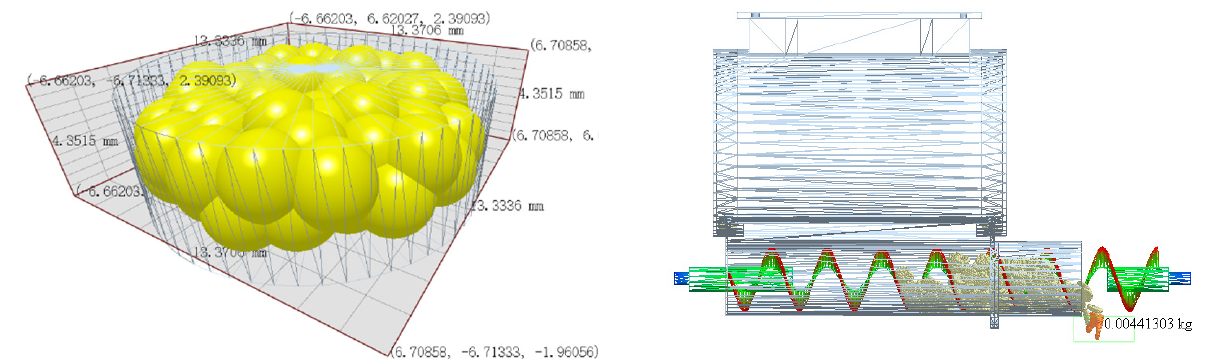
Figure 16. Simulation experiment of digital twin model for rhizome TCM particles.